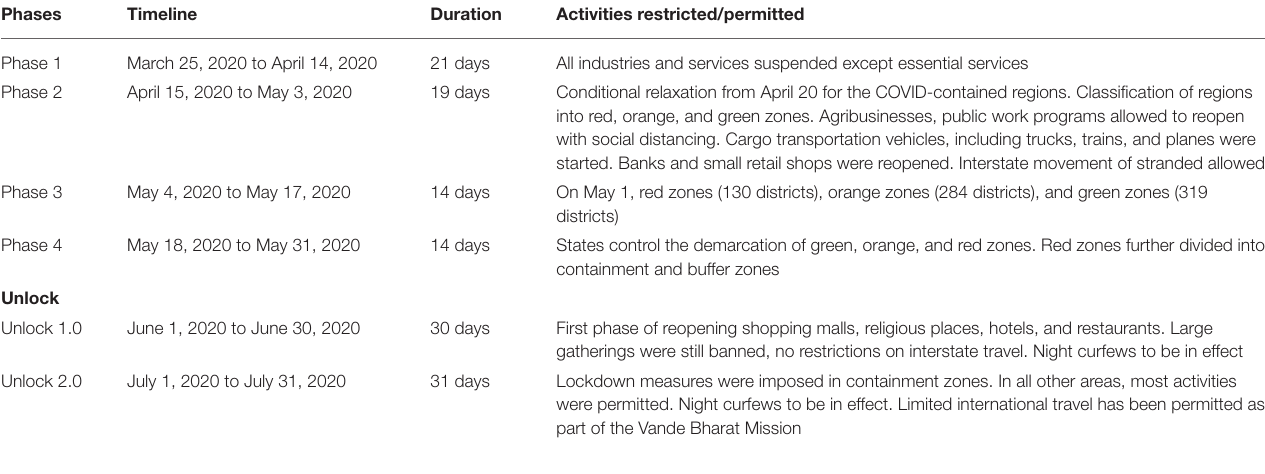
TABLE 1 | Different timelines that India adopted for lockdown and unlock phases.